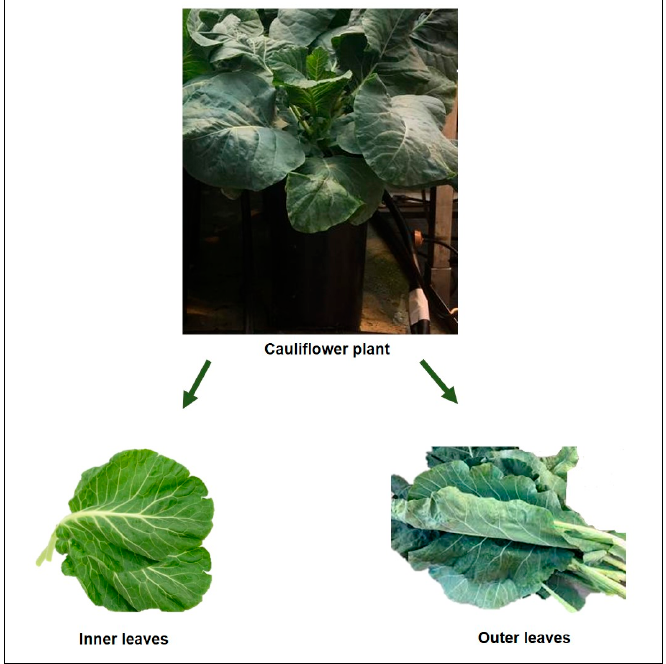
Figure 1. The physical characteristics of cauliflower.